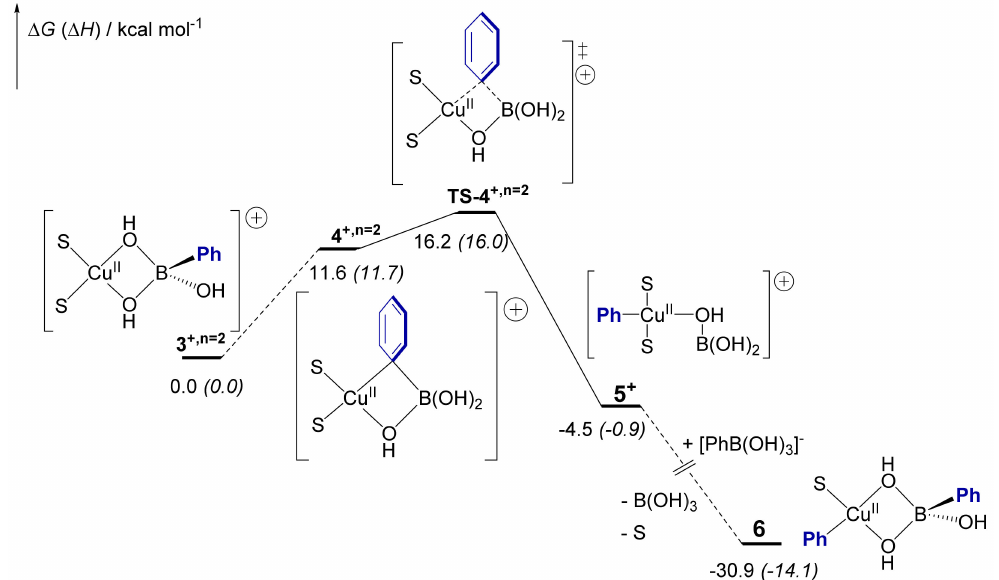
Figure 5. Reaction profile of the Cu-to-B transmetalation in the heterobimetallic cationic intermediate [(S) 2 Cu( µ -OH) 2 B(Ph)(OH)] + ( 3 +,n = 2 ) (S = MeOH) computed at the DFT level. ∆ G ( ∆ H ) are given in kcal mol − 1 . See Figures S14–S16 for alternative